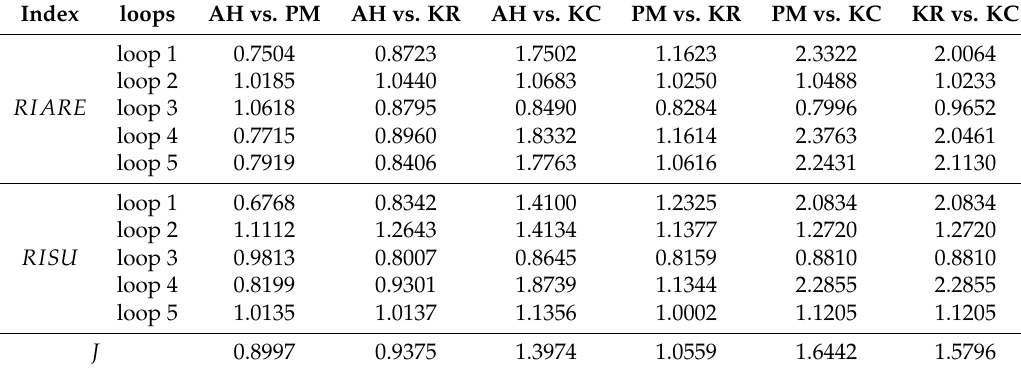
Table 6. Performance indexes for RIARE , RISU and J (the controllers are compared in order of C 2 vs. C 1 , according to Equations (45) and